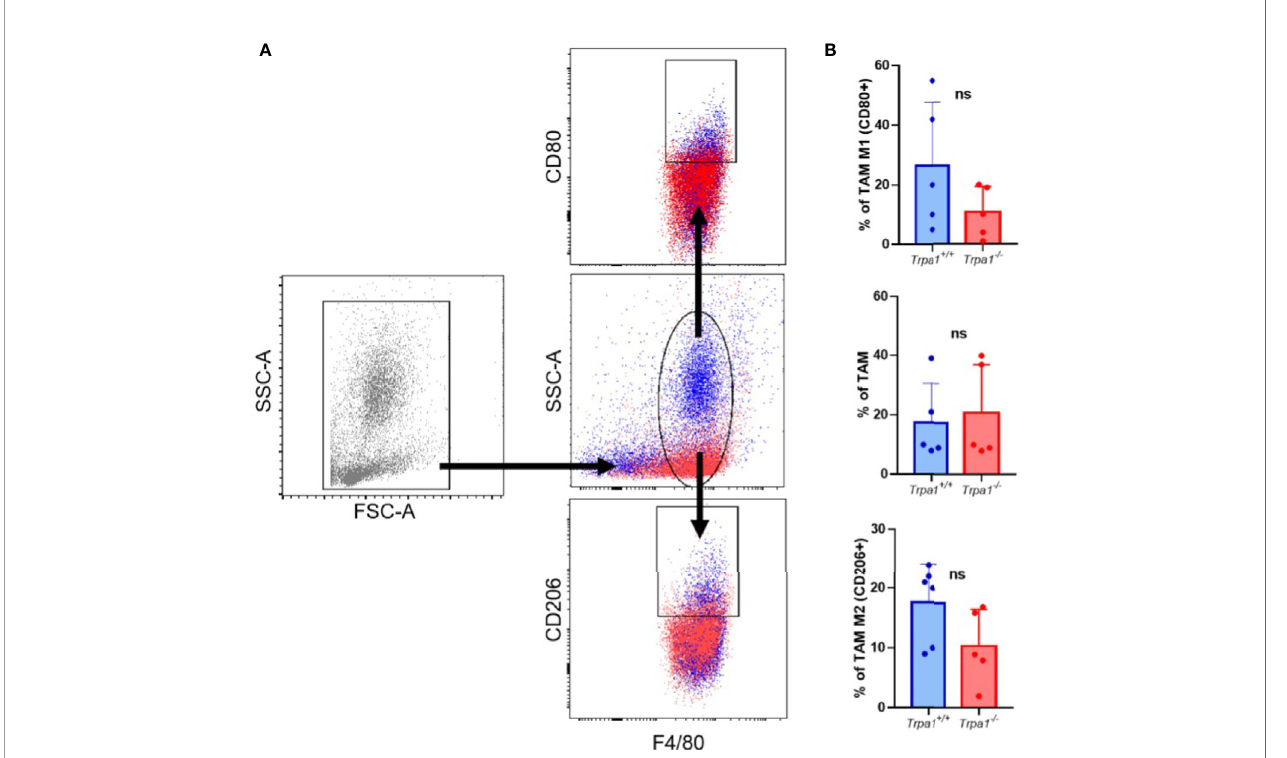
FIGURE 3 | Evaluation of tumor-associated macrophages (TAM) from Trpa1 +/+ or Trpa1 -/- mice. (A) Gating strategy for the de fi nition of TAM populations; (B) Analysis of frequency of TAM in tumors. Subpopulations of M1 and M2 TAM were analyzed. Values are presented as the mean (n = 5) ± SD of the frequency (%) in each group. ns, not signi fi